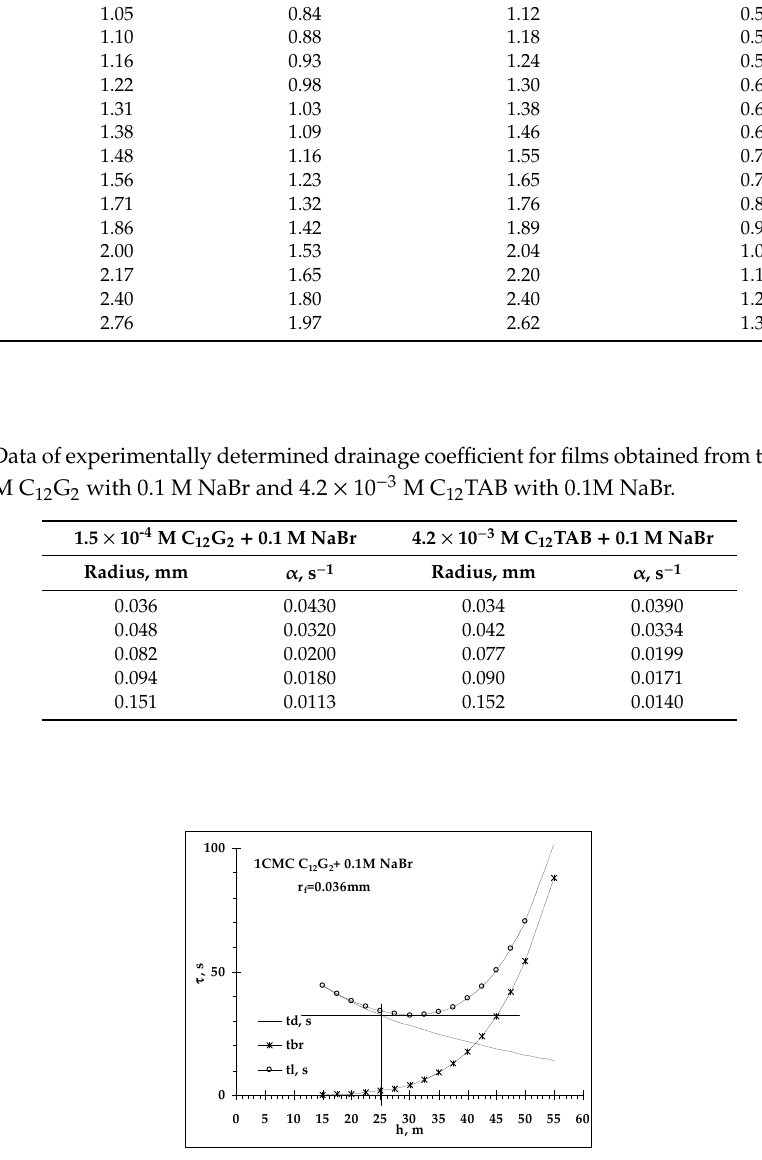
( ) h brbr τ=τ calculated by Equation (5) using the non- 324 ( ) h ll τ=τ calculated similar to a sum from τ d and τ br ] . 325